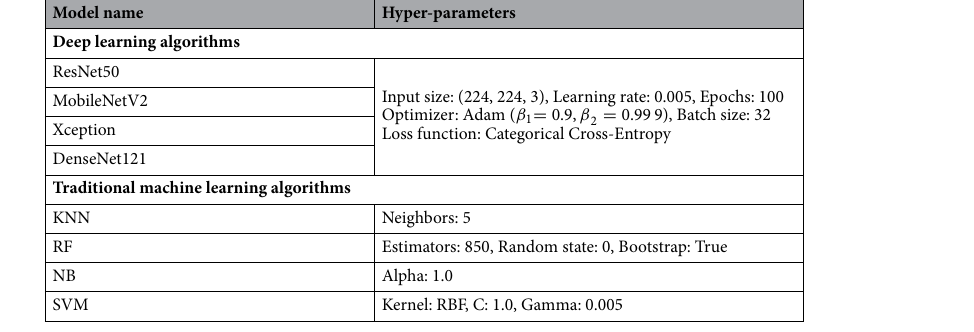
Table 2. Hyperparameter settings for each classifier.